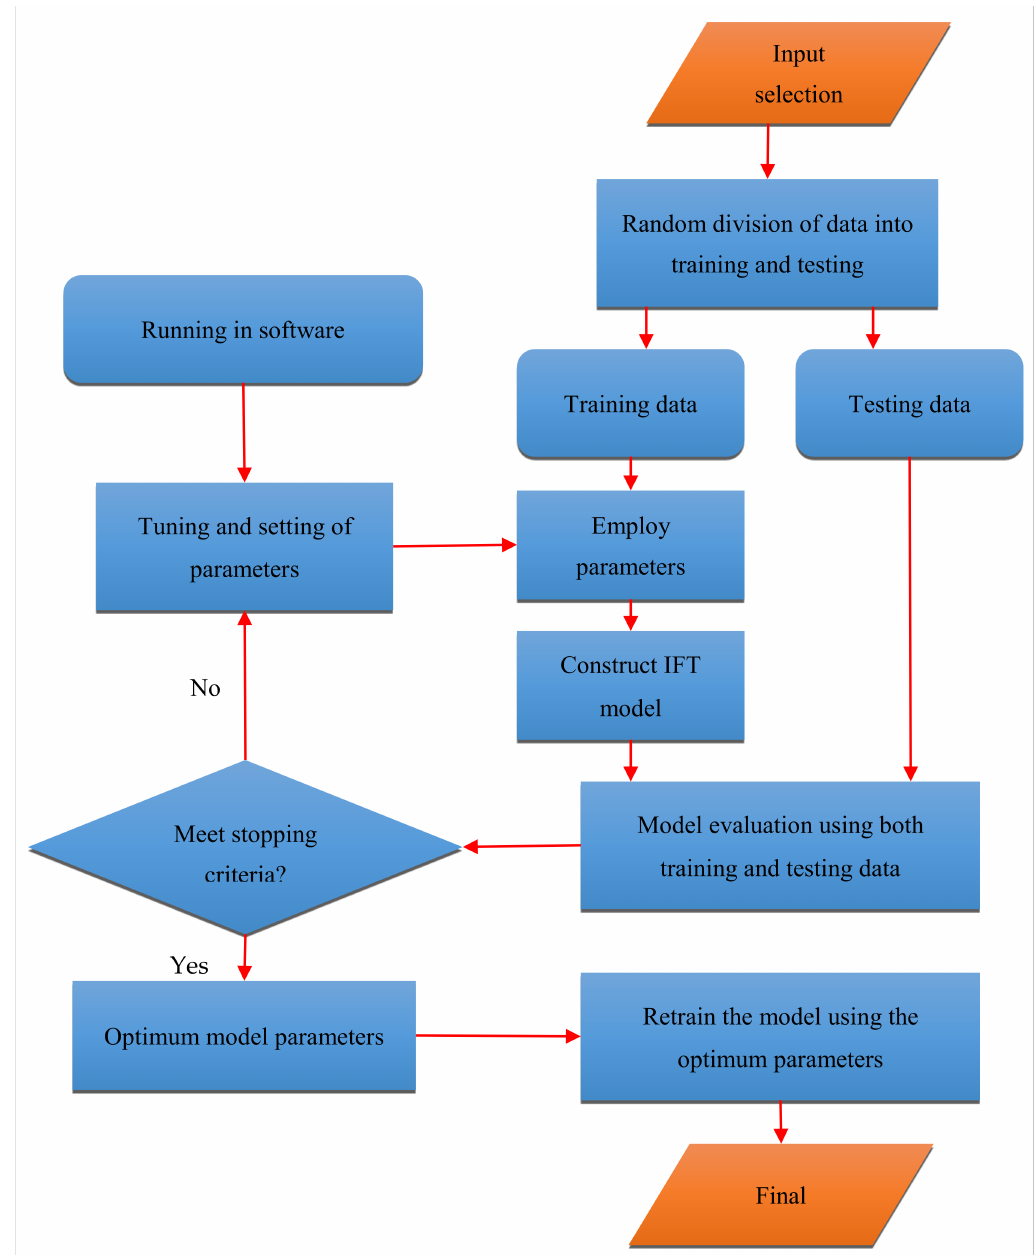
Figure 1. A schematic flowchart of the applied algorithms for the development of IFT